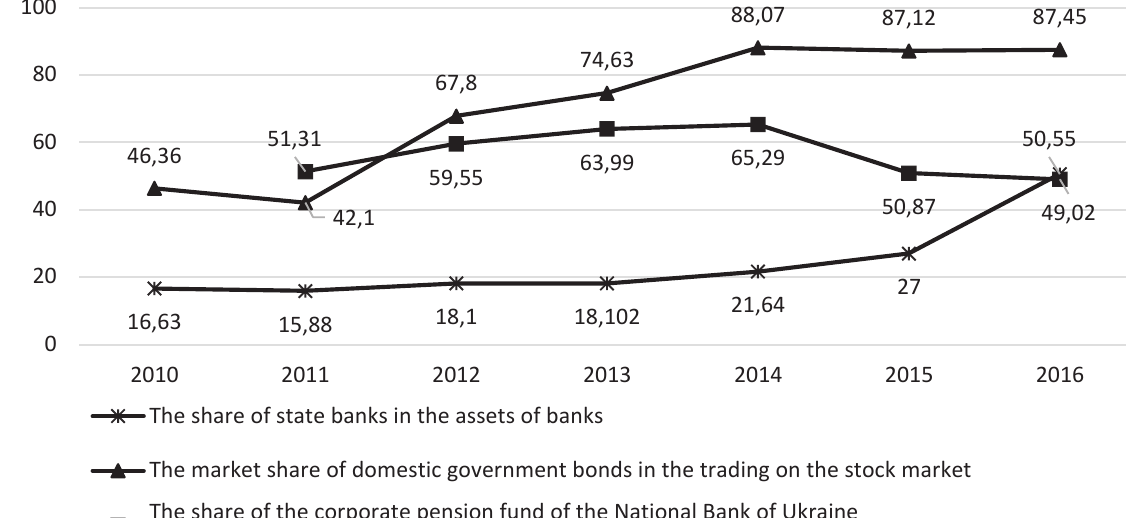
Figure 2. The share of public finance in the financial system of Ukraine, % (compiled by the author based on the data of the National Bank of Ukraine, the National Securities and Stock Market Commission, the National Commission for Regulation of Financial